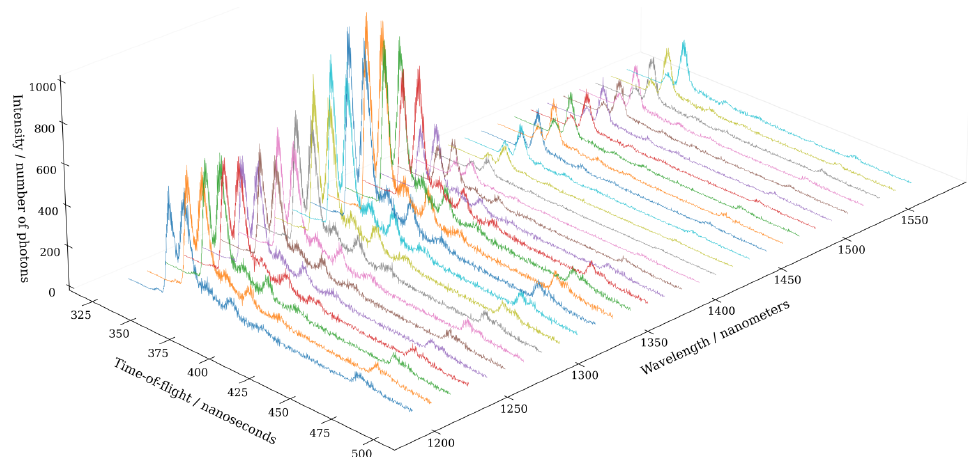
Figure 10. Time-of-flight histogram for each individual wavelength channel. The return waveform from the spruce ( Picea abies ) target shows multiple echoes originating from the needles, pulvinus, branches, and the trunk of the tree. Additionally, the echoes from trees located behind the main target are visible in the data. The intensity has been computed as a sum over 10,000 frames.